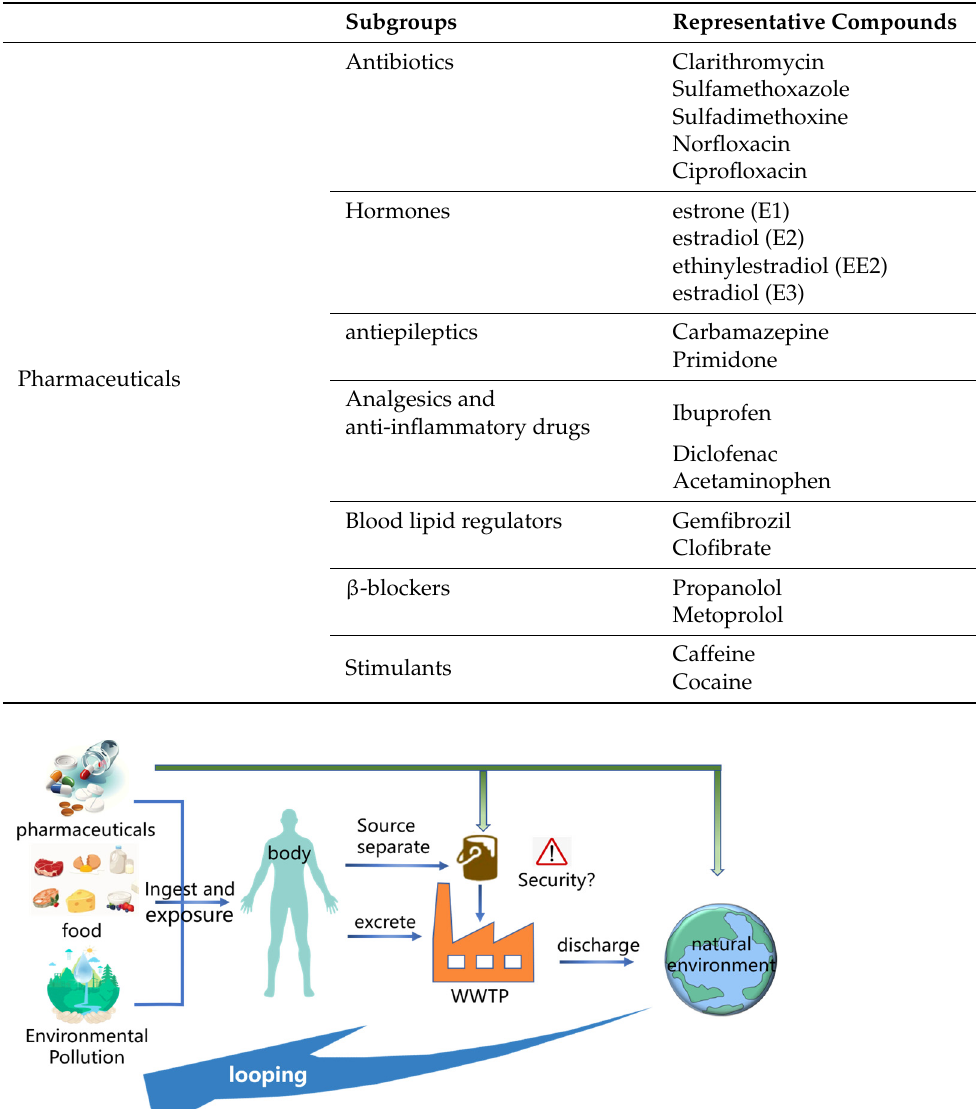
Table 1. Classification of pharmaceutical contaminants.